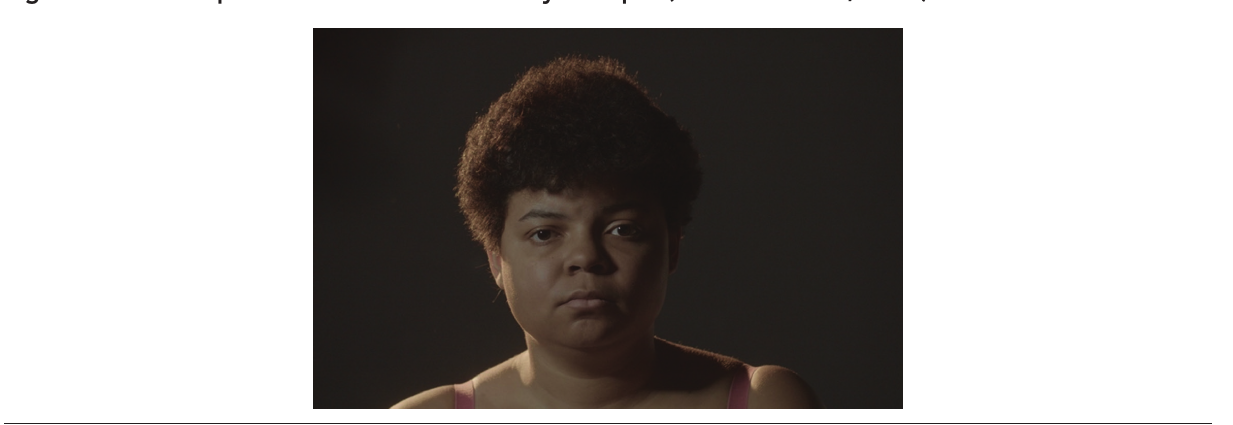
Figure 14. Close-up shot with anxious mood by Group 3 (Source: Author, 2022)